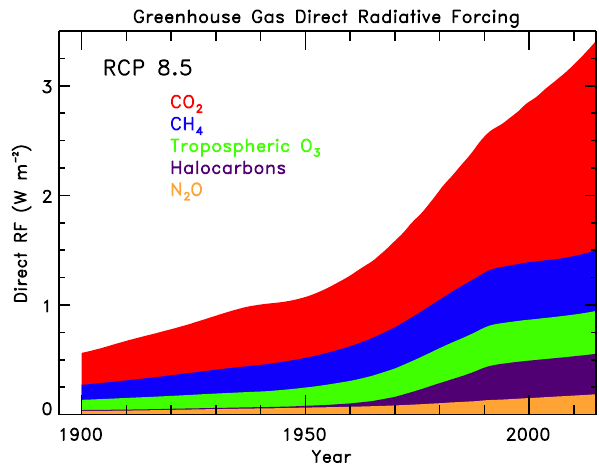
Fig. 1. Direct RF due to greenhouse gases (GHG RF) used as in- put for all model calculations. The coloured regions show individ- ual contributions from CO 2 (red), CH 4 (blue), tropospheric O 3 (or- ange), halocarbons (green) and N 2 O (purple), all based on global, monthly mean mixing ratios from the RCP 8.5